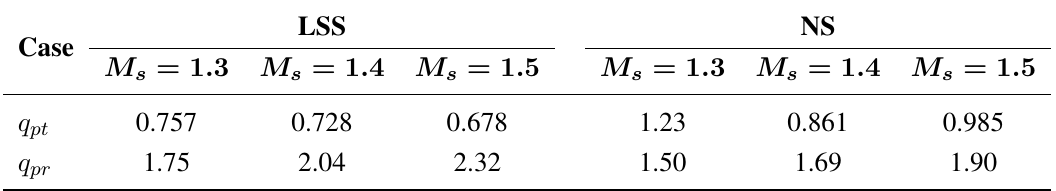
Figure 8. Dimensionless pressure, p , along the centerline of ( a ) LSS and ( b ) NS for n M = 1 . 3 , 1 . 4 and 1 . 5 at time instant t = 500 µ s. s Table 4. The ratio of the peak pressure measured behind the transmitted and reflected shocks along the centerline of the shock tube at time t = 500 µ s to the initial high pressure behind the incident shock, q and q , where the subscript t denotes transmitted shock and r denotes pt pr reflected